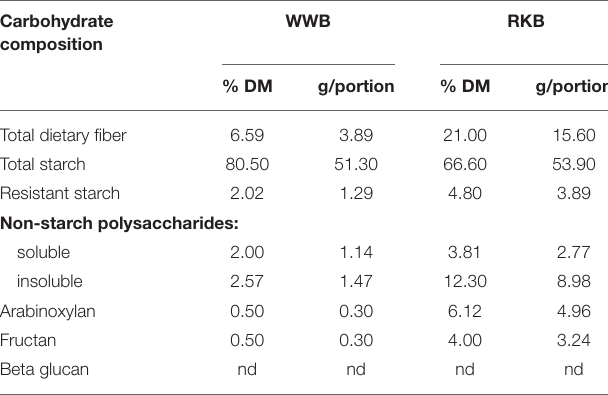
TABLE 1 | Carbohydrate composition of reference white wheat bread (WWB) and rye kernel bread (RKB). Carbohydrate